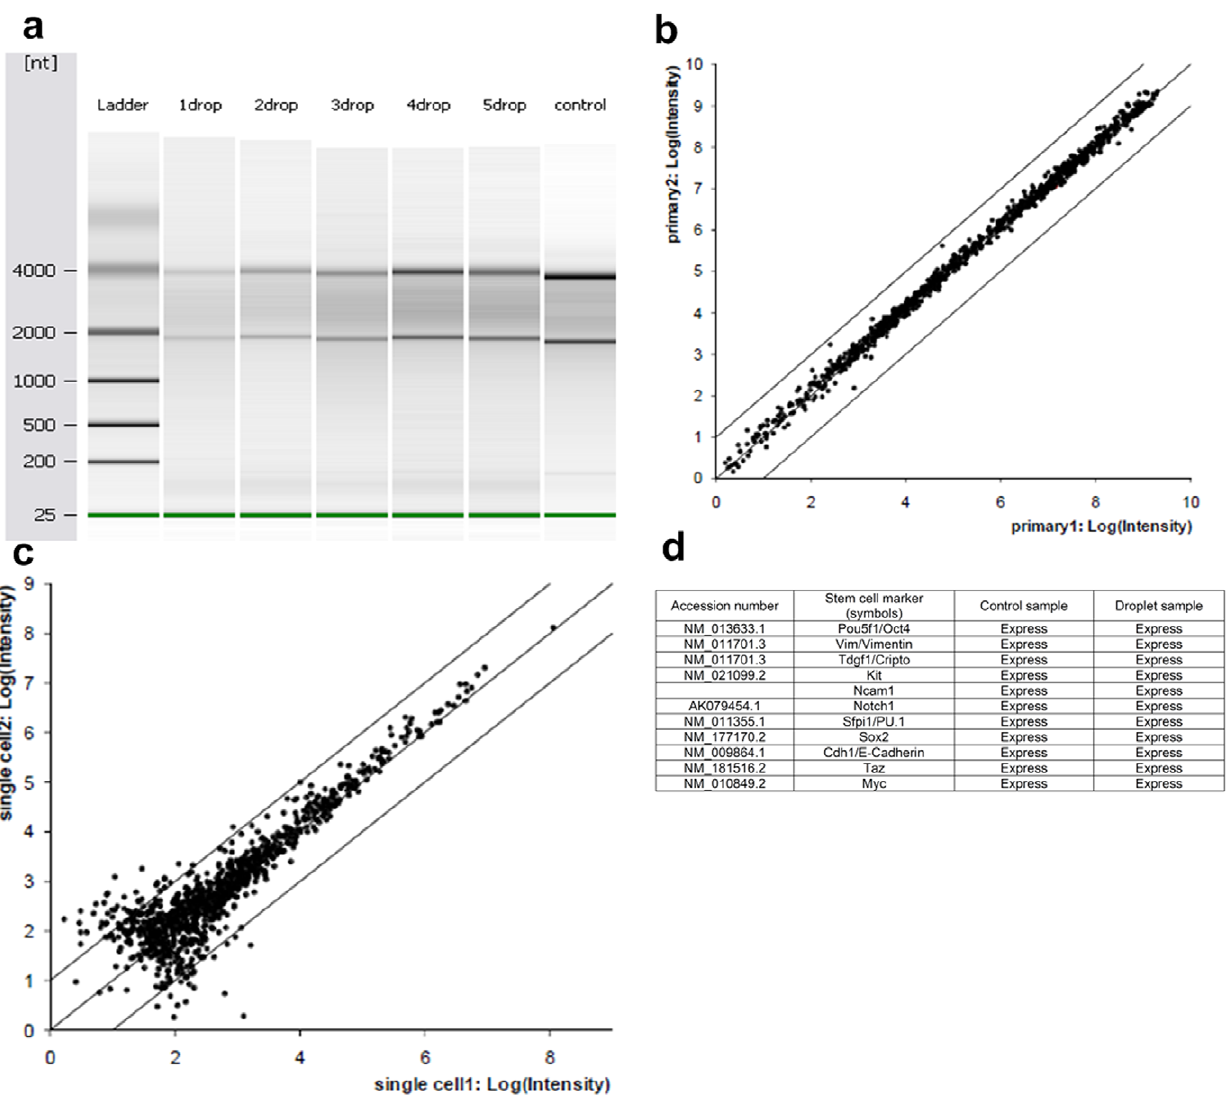
Figure 4. Total RNA expressions in printed droplets (virtual gel). ( a ) Total RNA quality on virtual gels (Agilent bioanalyser) as number of droplets increase. The 96-well plate was then placed underneath the ejector and one droplet was ejected into each of the first nine wells of the first row of wells. This procedure was repeated with additional four rows of the plate, where two, three, four and five droplets were ejected in each well resulting to a total of five groups of droplet samples, each group having an increasing droplet volume and increasing number of cells ranging from ten to fifty cells. For extraction purposes and consistency, before the RNA analysis was performed, each row was divided into three triplicates. Hence, the analysis was based on average 30, 60, 90, 120, and 150 cells for each triplicate for bioanalysis. To investigate nonprinted cells, 0.5 m l samples were drawn from the cell solution and pipetted into the three wells in each of the first three rows of the plate as controls. The controls had 1000 cells on average. The last lane showed the results for the control RNA which was prepared by a manual dilution method without ejection. ( b , c ) Comparison of the reproducibility of the RNA expression levels for ( b ) two replicates of the control set by the manual pipette method and ( c ) two experimental RNA samples obtained by droplet method. The scatter-plots were compared the reproducibility of expression level measurements for the 1000 genes with the highest expression levels in the experimental samples. ( d ) Expression of stem cell-related markers was examined to assess whether RNA obtained from the cell encapsulating droplets provided useful biological information in comparison to control samples. Our results showed that these 11 stem cell markers including Kit and Notch1, were found in both the patterned cells and the control groups.